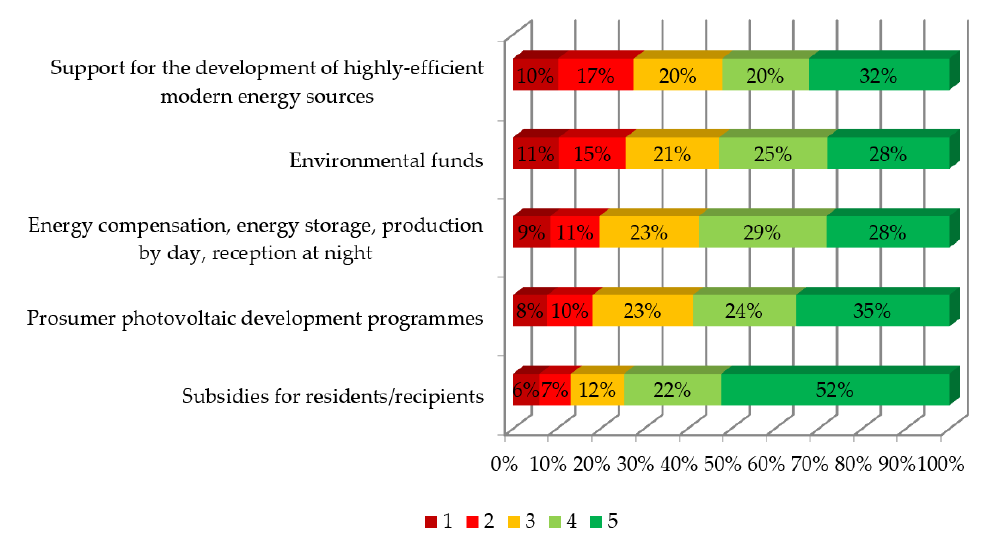
Figure 3. Which decarbonization activities should be financed from local funds. Source: Own study based on research, n = 444.